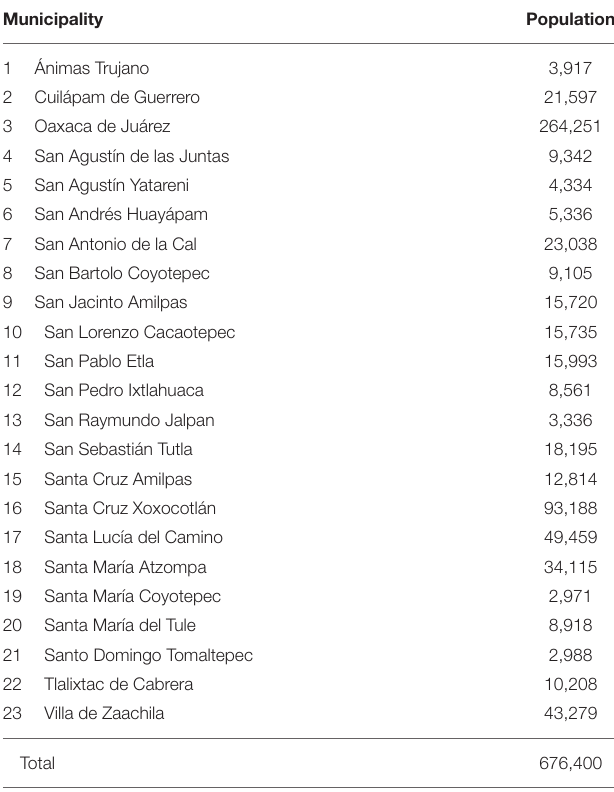
TABLE 5 | ZMVO composition and population in 2015 (INEGI, 2016).